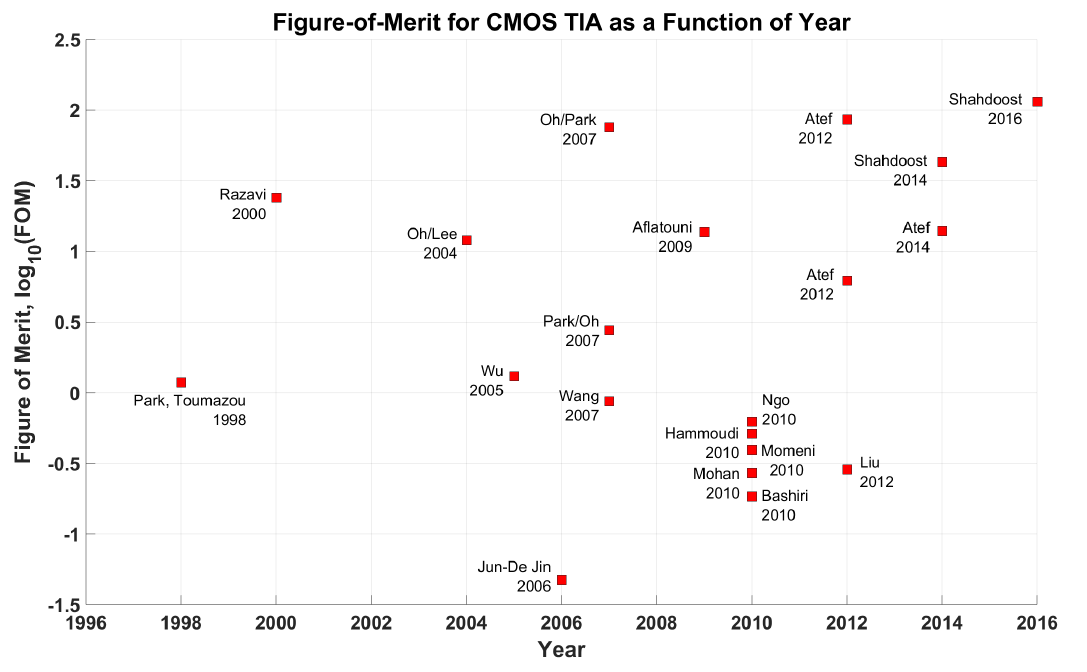
Figure 15. The FOM-based performance of the reported CMOS TIA depending on the year of publication.